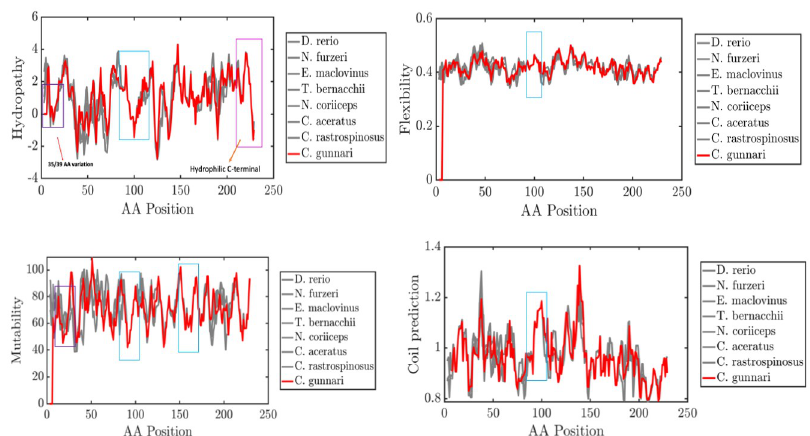
Fig 6. Primary sequence features of ATP Synthase F 0 subunit 6 in species C . gunnari (red), C . rastrospinosus , C . aceratus , N . coriiceps , T . bernacchii , E . maclovinus , N . furzeri and D . rerio . Red Box: N-terminal property changes, Purple Box: Changes in properties observed at 35/39 variation, blue box: Conserved regions 90–170 (Active site 160– 169), Pink Box: C-terminal low hydrophobicity. A difference in the peaks have been observed for different properties (highlighted) such as molecular weight and hydrophobicity of amino acid residues across the sequence and